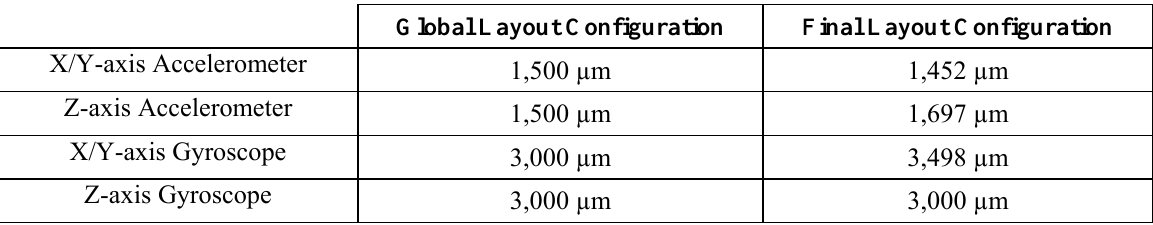
Table 8. Comparison of the equivalent side length with parameters adjusted.